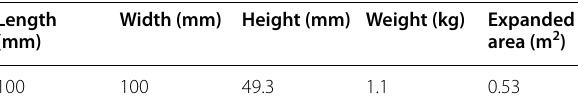
Table 2 Parameters of solar sail Length (mm)